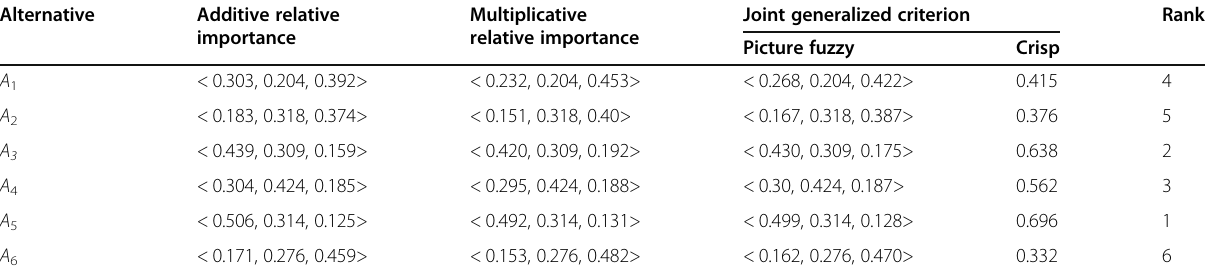
Table 3 The additive and multiplicative relative importance, joint generalized criterion values, and ranks of the LMD modes Alternative Additive relative Multiplicative Joint generalized importance relative importance